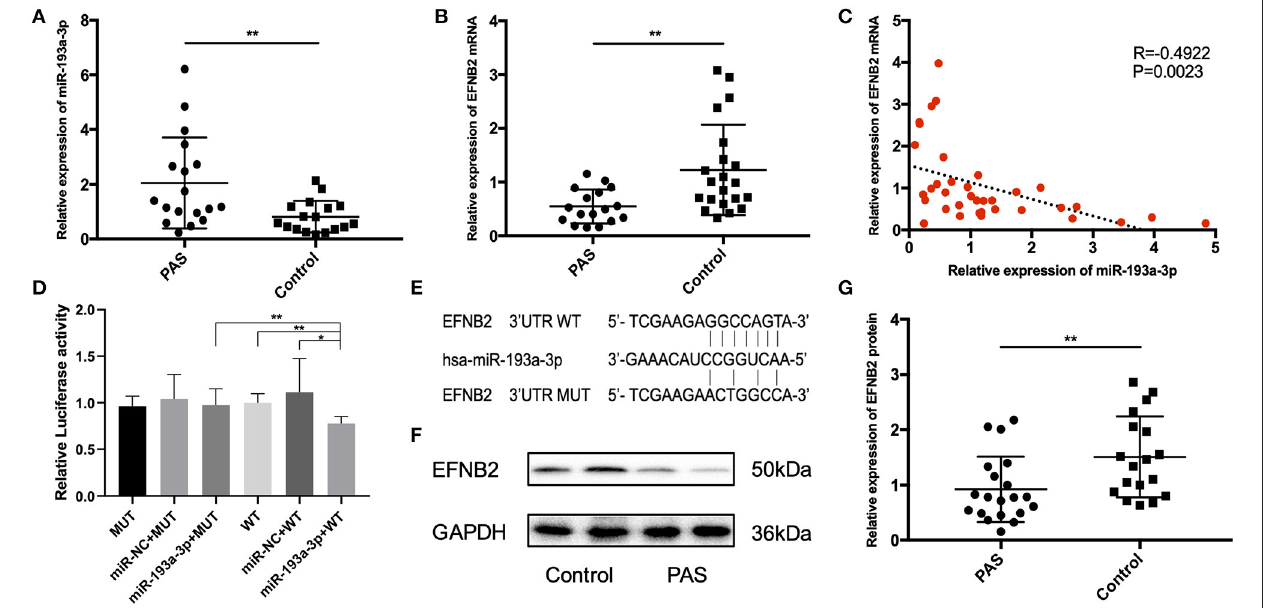
FIGURE 1 | Differential expression of miR-193a-3p and EFNB2 in placenta accreta spectrum tissues. (A) miR-193a-3p expression was higher in placental tissues of PAS patients than in those of control patients on qRT-PCR. (B) EFNB2 mRNA levels in placental tissues. (C) A negative relationship was evident between miR-193a-3p and EFNB2 mRNA in placental tissue samples. (D) Relative luciferase activities determined in cells co-transfected with WT or MUT EFNB2 3 ′ -UTR and control, miR-NC, or miR-193a-3p. (E) The binding site of miR-193a-3p with WT or MUT EFNB2 3 ′ -UTR. (F) Differential expression of EFNB2 protein examined in placental tissues, showing that the expression level of EFNB2 was significantly lower in PAS than in control. (G) The gray value measurement method quantitatively analyzes the expression difference of EFNB2/GAPDH in each group. All data are presented as the mean ± standard deviation. PAS, placenta accreta spectrum; EFNB2, Ephrin-B2; miR, microRNA; UTR, untranslated region; WT, wild type; MUT, mutant type; NC, negative control. * P < 0.05, ** P < 0.01.